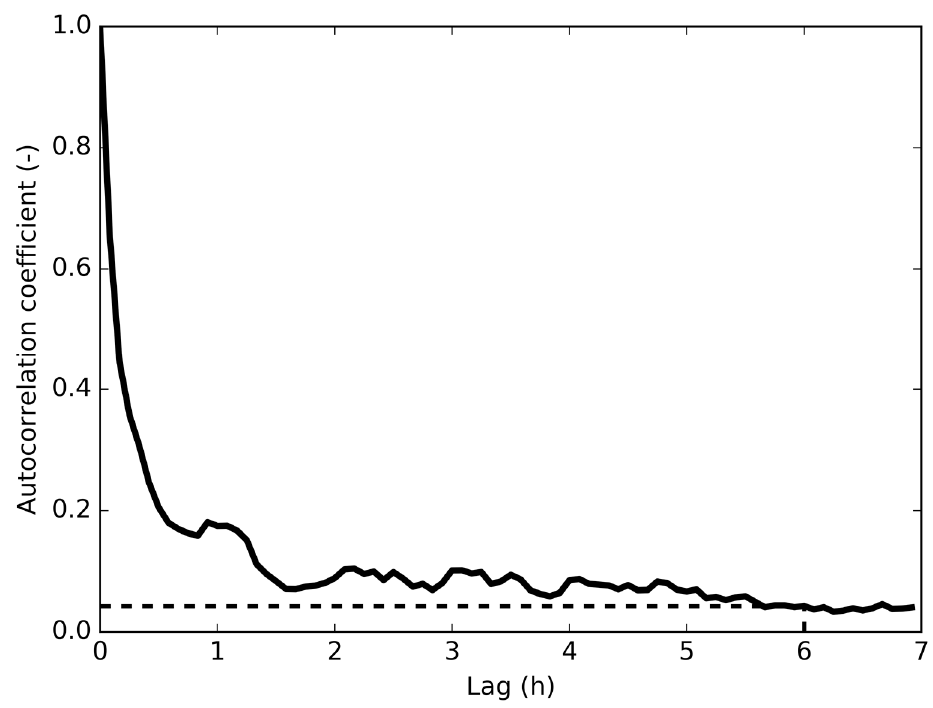
Figure 4. Autocorrelation plot for the precipitation depth at 5 min intervals. The precipitation events were considered independent if the inter-event time exceeded 6 h.